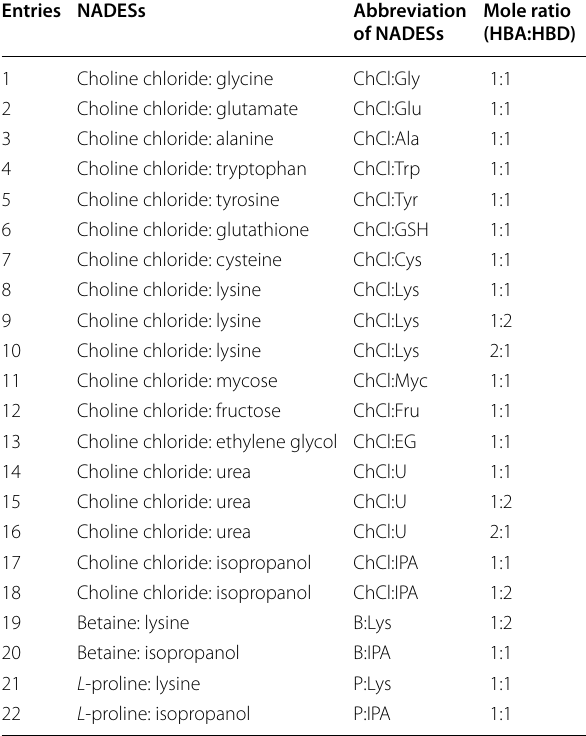
confirmed that ChCl:Lys (1:1) plays a role in promoting cofactor regeneration during 3’-(trifluoromethyl)aceto- phenone bioreduction catalyzed by recombinant E. coli cells.